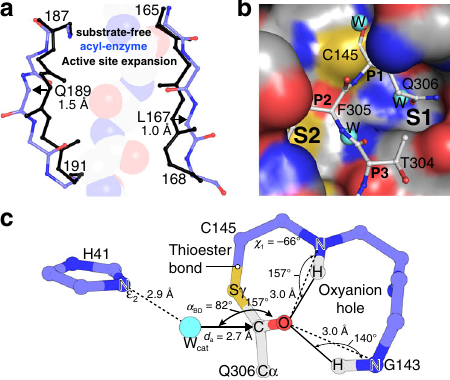
Fig. 2 Comparison of wild-type acyl-enzyme intermediate and substrate- free M pro structures. a Superposition of the substrate-free (black) and acyl-enzyme (blue) forms reveals changes in the substrate binding groove width. The main chain atoms for bound B ′ substrate are shown as transparent van der Waals spheres. b Molecular surface of wild-type M pro with three-ordered water molecules (cyan spheres). Superposition of the acyl-enzyme structure shows these waters are coincident with oxygen atom positions and will be displaced upon substrate binding. c Analysis of the wild-type acyl-enzyme active site reveals a potential deacylating water (catalytic/nucleophilic – W cat ) approaching the Re - face of the thioester. Ball and stick diagram depicting the geometry and atomic interactions of the thioester linkage between the S γ of Cys145 and main chain carbonyl carbon of substrate Gln306. The trigonal planar nature of the thioester group, de fi ned by atoms C α , C, and O of Gln306, and S γ of Cys145 is shown as is the χ 1 dihedral angle (de fi ned by atoms N, C α , C β , and S γ ). The oxyanion hole hydrogen bond distances and angles are also labeled. Proposed deacylating water ( W cat ) shown as a cyan sphere. α BD is the Bürgi – Dunitz angle ( W cat - C = O) and d a the attack distance.